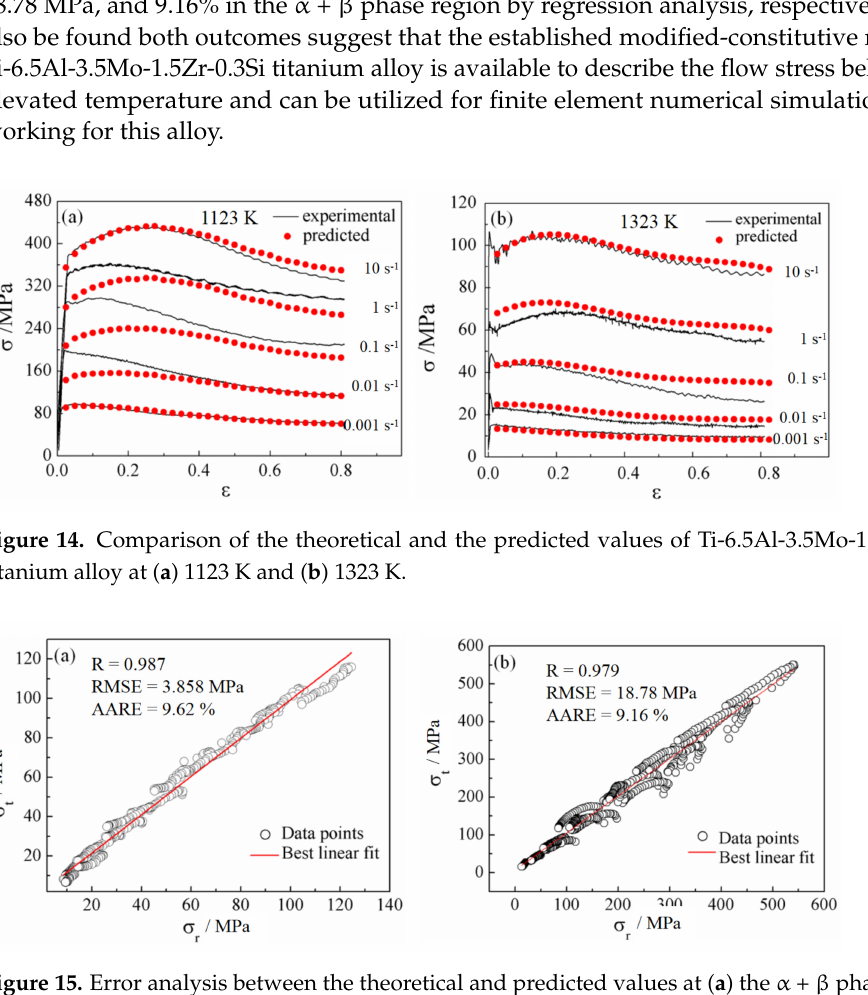
Figure 15. Error analysis between the theoretical and predicted values at ( a ) the α + β phase region and ( b ) the β . phase